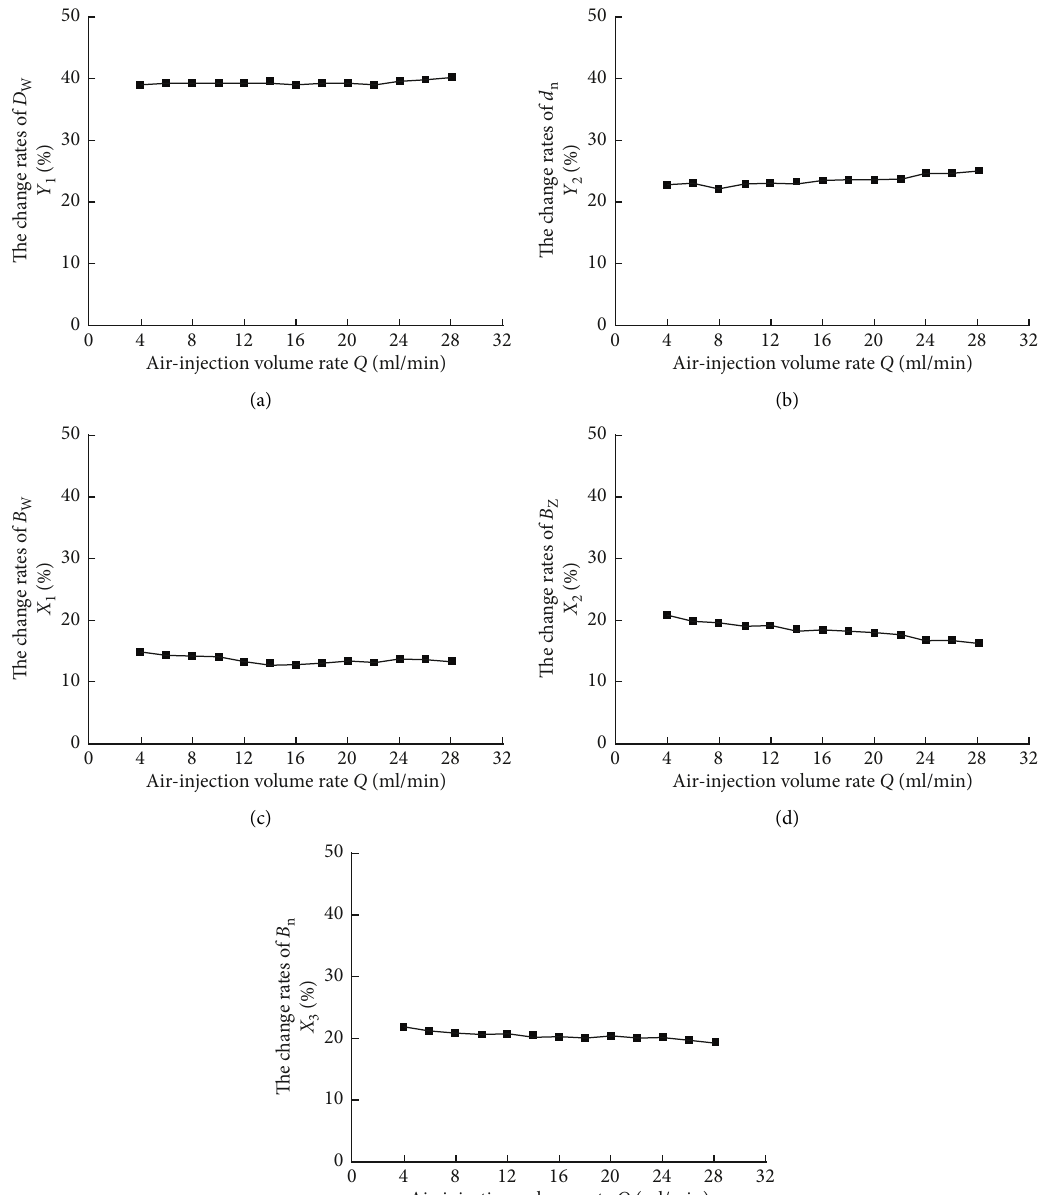
Figure 8: Diameter change rates ((a) outer and (b) inner diameters) and wall thickness change rates ((c) outer layer, (d) middle layer, and (e) inner layer wall thicknesses) of three-layered balloon catheters as a function of air injection volume